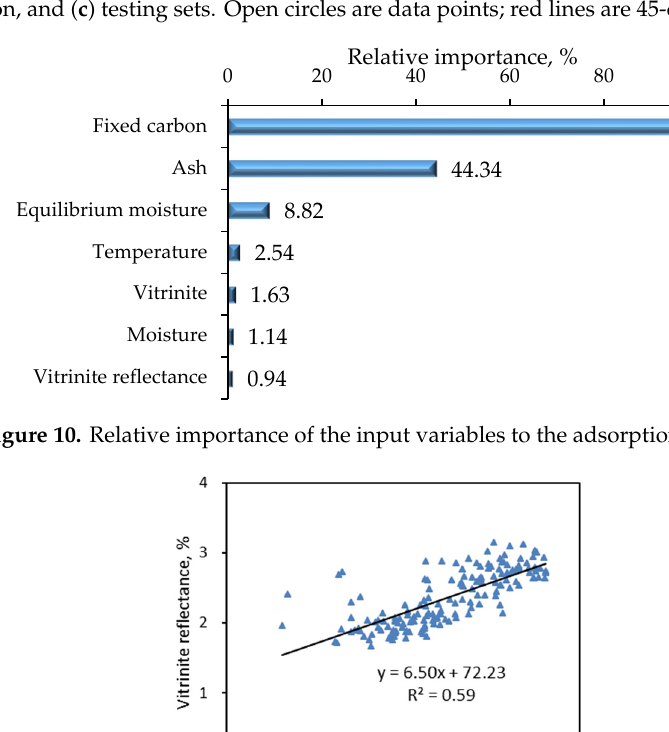
Figure 9. Cross plot of the SVM estimated versus measured adsorption amounts for the ( a ) training, ( b ) validation, and ( c ) testing sets. Open circles are data points; red lines are 45-degree lines.